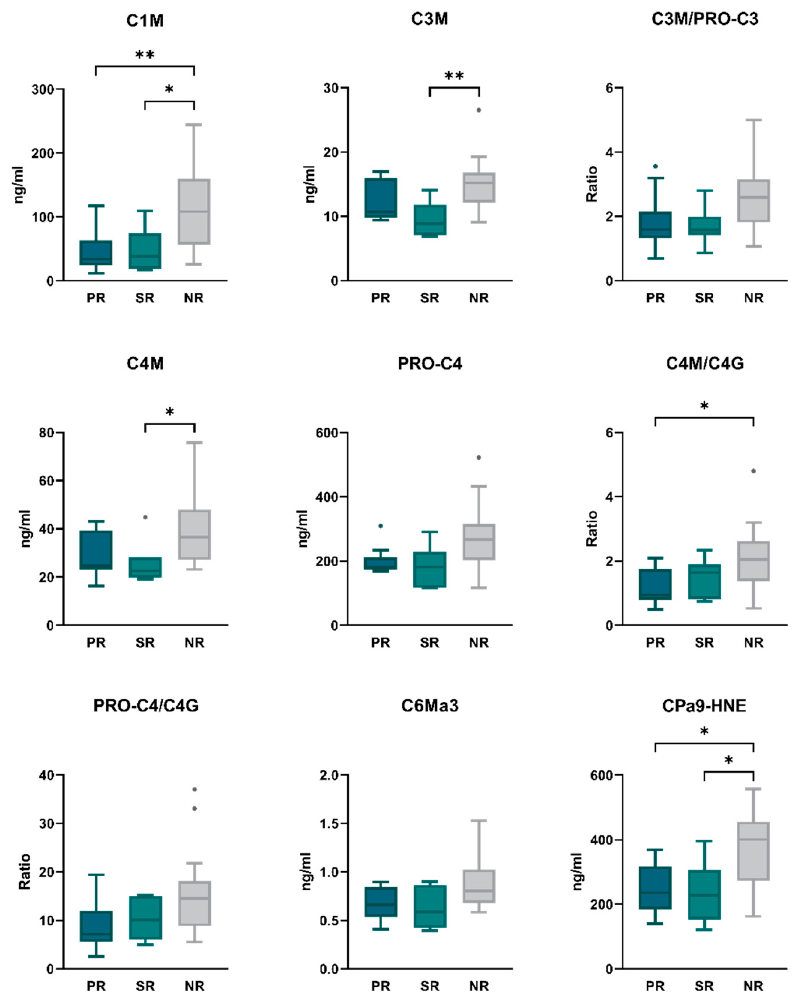
Figure 2. Baseline serum biomarker levels between primary responders (PR), secondary responders (SR), and non-responders (NR) to VEDO treatment. Biomarker levels are presented as Tukey boxplots. * p < 0.05; ** p < 0.01.